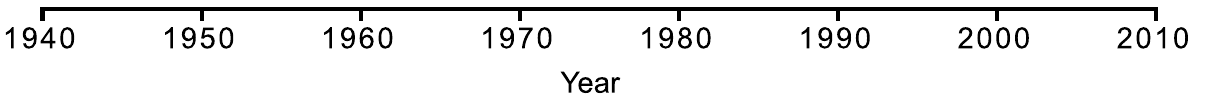
Figure 5. Bayesian phylogenetic reconstruction and divergence date estimates of the P.aeruginosa DK2 clones. Bayesian statistics were used to estimate the divergence times of predicted ancestors. The tree was based on 736 unique SNPs identified from whole-genome sequencing. Circles labeled A1, A2, B1, B2, C1, and C2, respectively, denotes the position of the first and last genotype of each of the DK2 sub-lineages A, B, and C which were observed to have infected patient CF173. The position of CF173-1991 (A2) is approximated from an equivalent Bayesian phylogenetic analysis including the hypermutator isolates (Figure S3). doi:10.1371/journal.pgen.1003741.g005 PLOS Genetics |